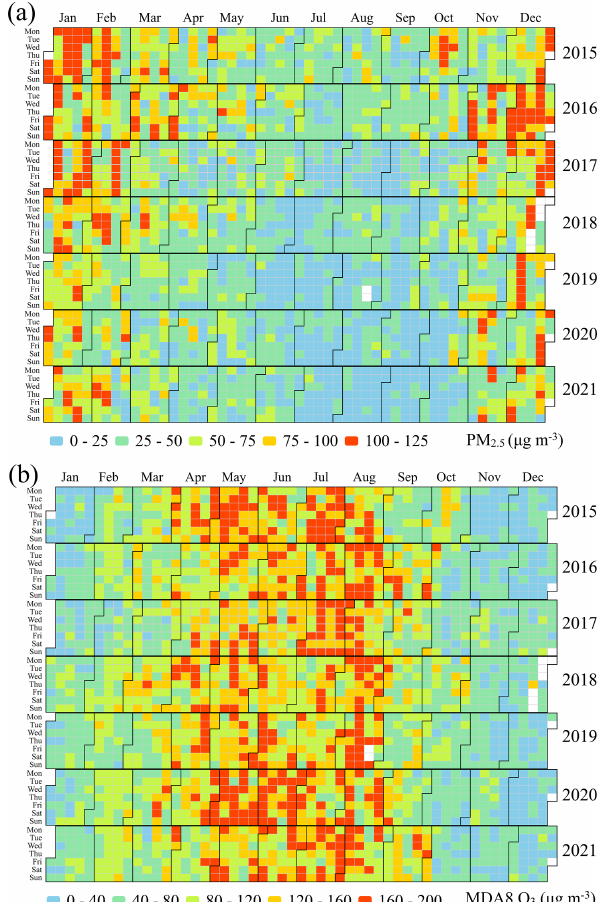
Figure 2. Heat maps of (a) daily PM 2 . 5 and (b) MDA8O 3 concen- trations in Chengdu from 2015 to